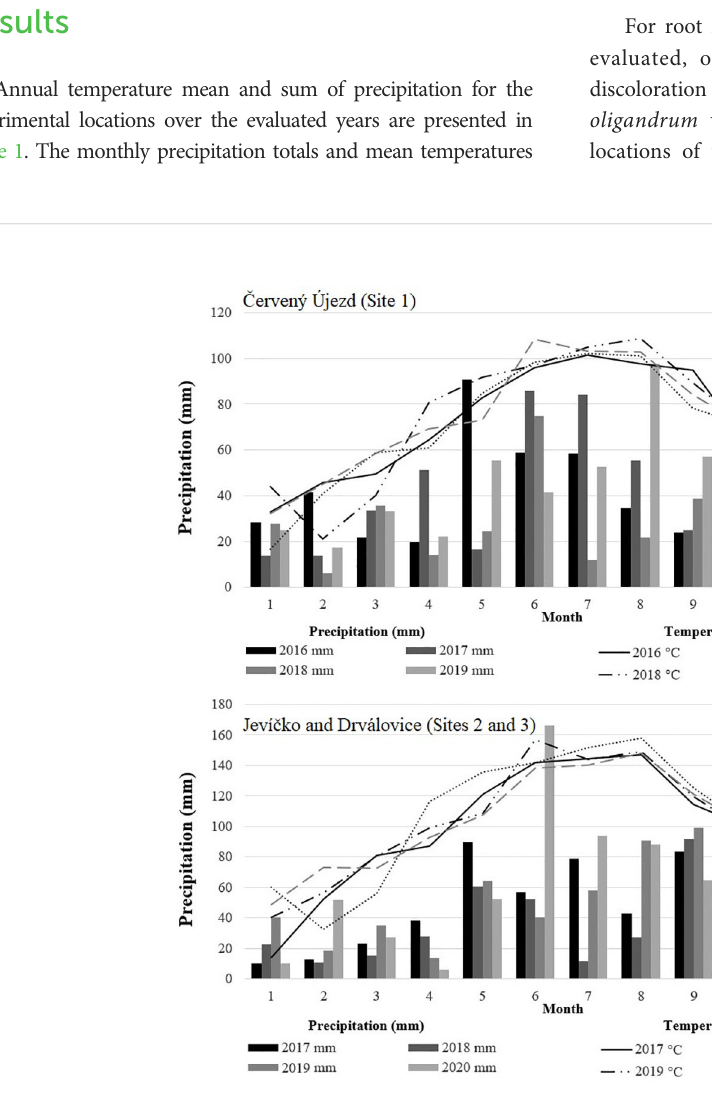
FIGURE 1 The monthly sums of precipitation and temperature means during the experimental years, from the meteorological station C ̌ erveny ́ U ́ jezd (Site 1) and Jev ı ́ c ̌ ko (Site 2 and 3), Czech